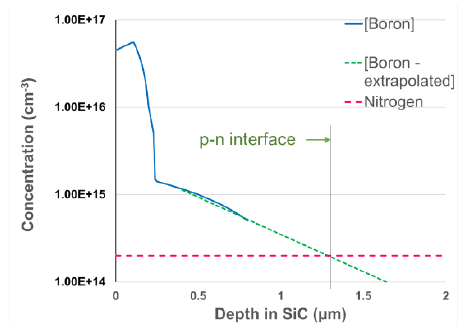
Fig. 6 Boron concentration distribution in SiC assuming a reduction of all boron concentrations by a factor of 1000 from those used in the as-built detector